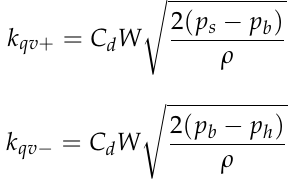
Figure 27. Power stage control block diagram.